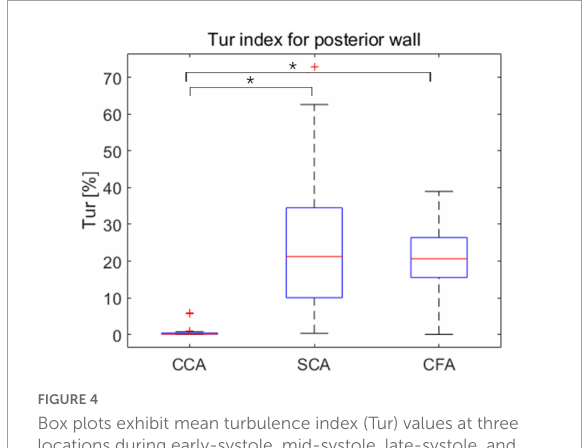
FIGURE4 Box plots exhibit mean turbulence index (Tur) values at three locations during early-systole, mid-systole, late-systole, and early diastole, with mean Tur values in healthy adult volunteers (vertical axis) corresponding to three sites (horizontal axis). CCA, common carotid artery; SCA, subclavian artery; CFA, common femoral artery. * P < 0.05.